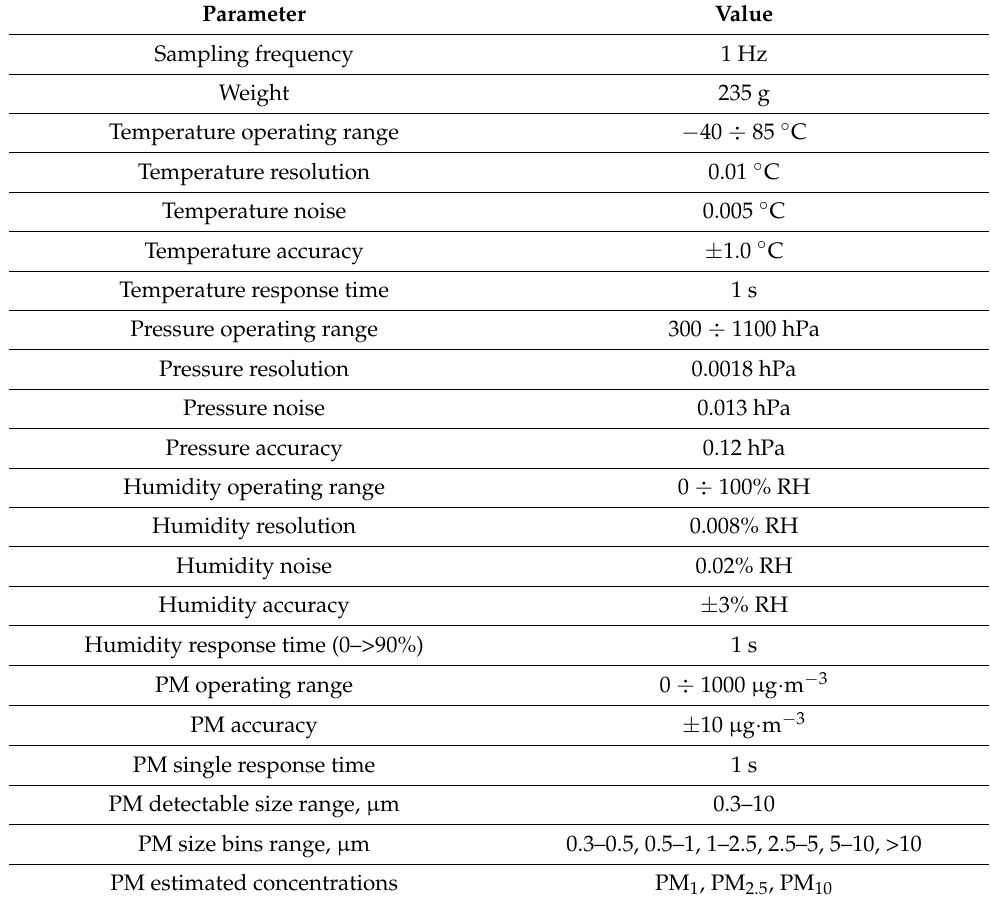
Table 1. System technical